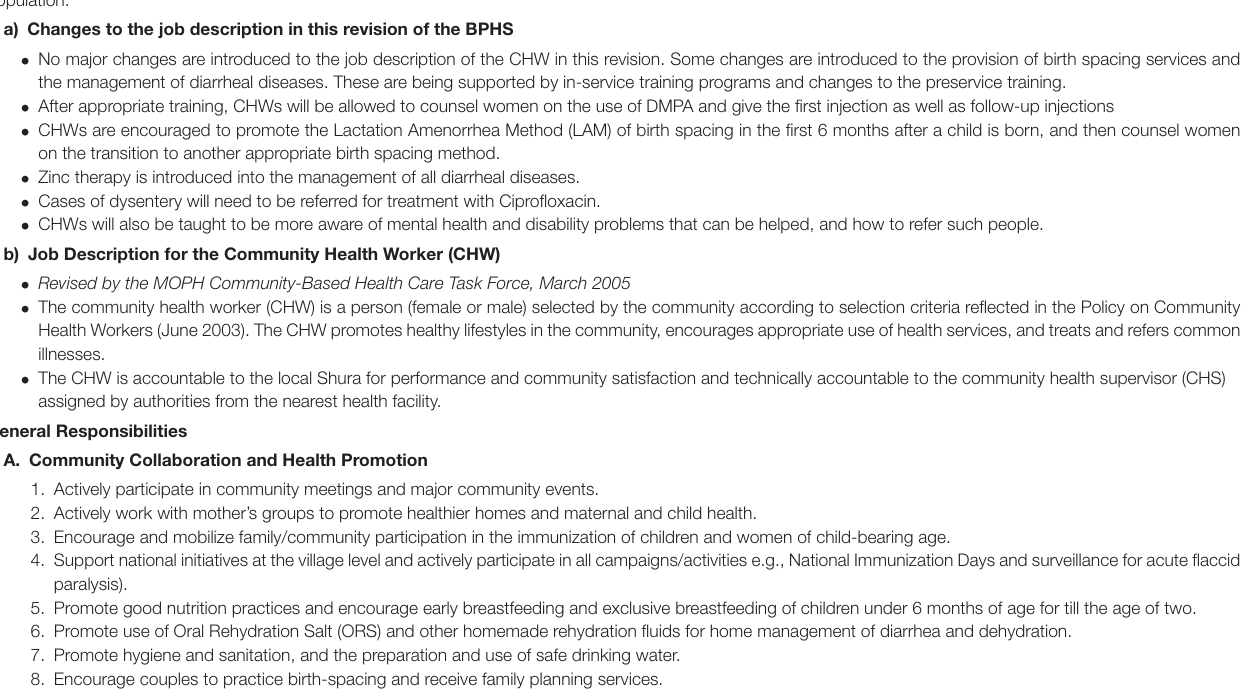
TABLE 1 | Selection criteria, roles, responsibilities and compensation of CHWs in Afghanistan [Excerpt from Basic Packages of Health Services, Ministry of the Public Health (4)]. The Community Health